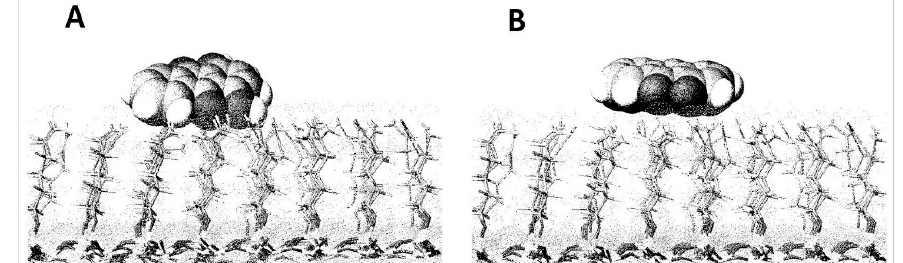
Figure 5. Model hexyl- and hexenyl-bonded silica gels: ( A ) Quinizarine carboxyl-group contacts with hexenyl vinyl group and ( B ) ionized quinizarine stays at top of hexyl-bonded phase. Black ball: oxygene. Gray ball: carbon. White Ball: hydrogen. Model phase atoms shown as dot form.